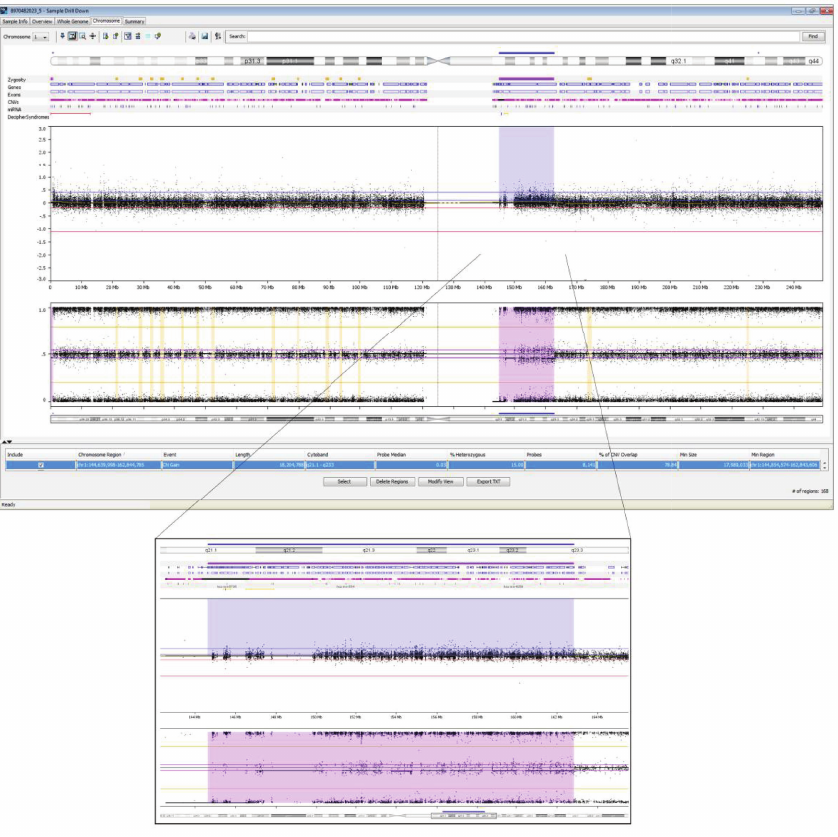
Figure 2: SNP-array analysis showed a mosaic duplication of ∼ 18.0Mb in 1q21.1-1q23.3: arr[hg19] 1q21.1q23.3(144,854,574-162,843,606) × 2 ∼ 3. The upper 𝑦 -axis shows the Log2 R ratio and the lower 𝑦 -axis indicates the B allele frequency.